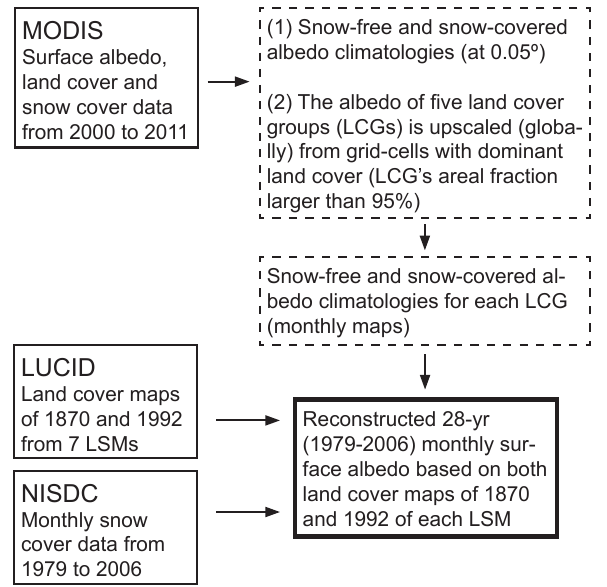
Fig. 1. Flowchart of the methodology used to compute surface albedo climatologies for land cover maps of 1870 and 1992 based on satellite